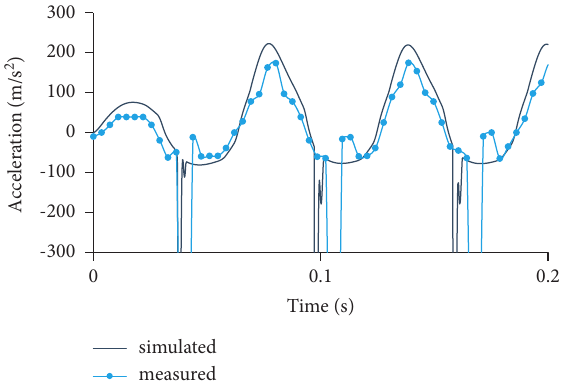
Figure 11: Comparison result of piston acceleration at 4bar. Table 2: Mean friction force at different inlet